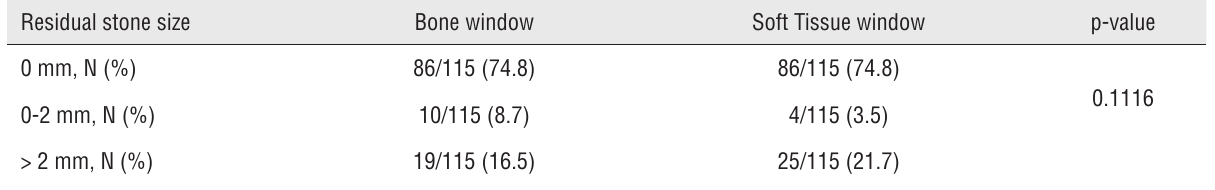
Table 2 - Comparison between post-operative NCCT bone and soft tissue windows of the residual stone size of the115 renal units. Residual stone size Bone window Soft Tissue